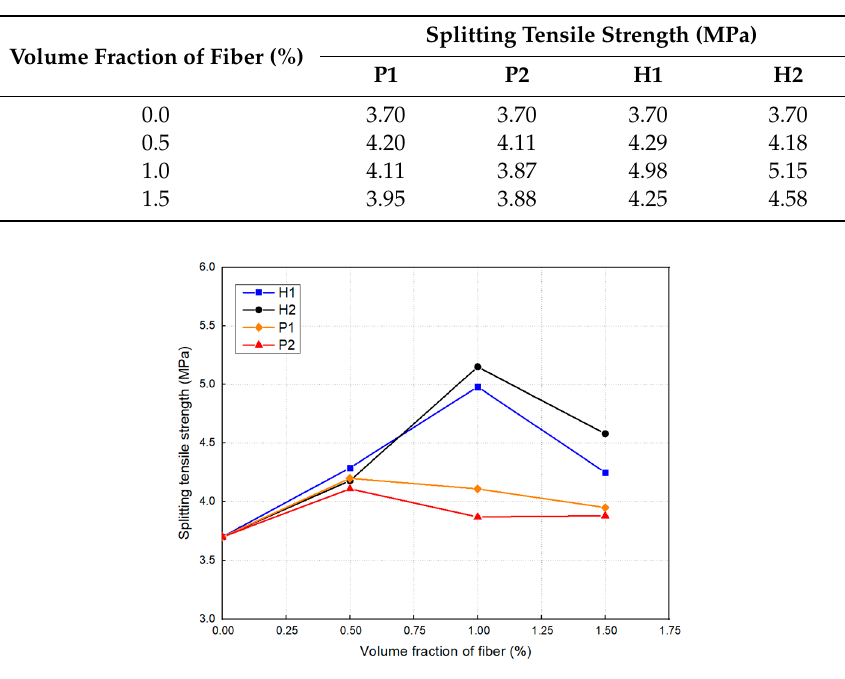
Figure 16. Splitting tensile strength.